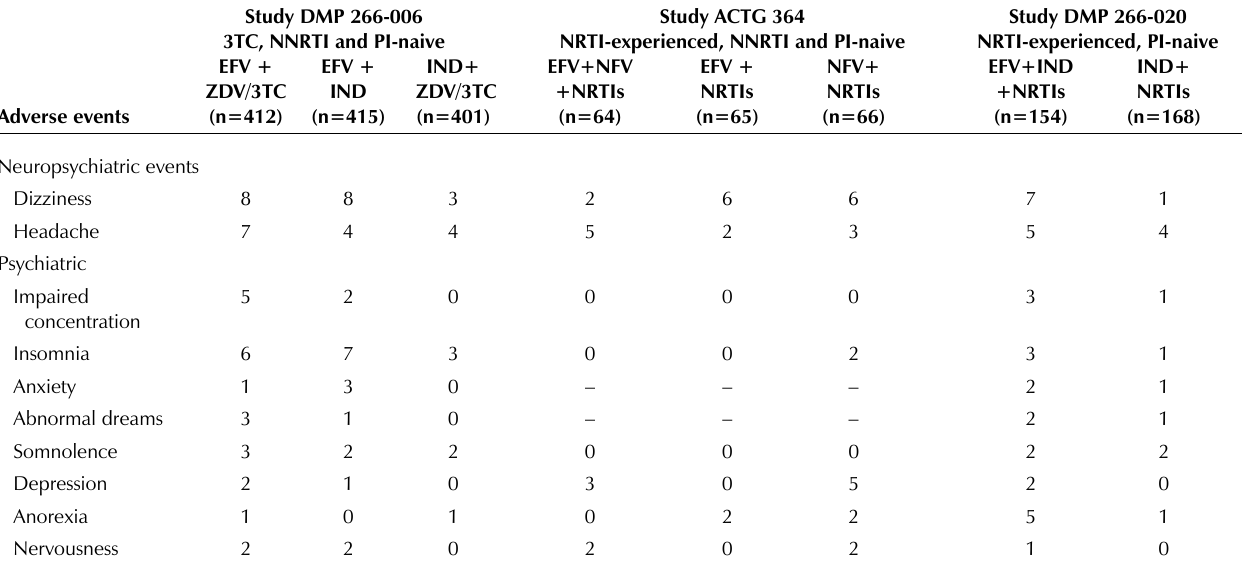
TABLE 2 Percentage of patients with treatment-emergent neuropsychiatric events of moderate or severe intensity reported in 2% or more of patients in Studies DMP 266-066, ACTG 364, and DMP 266-020 Study DMP 266-006